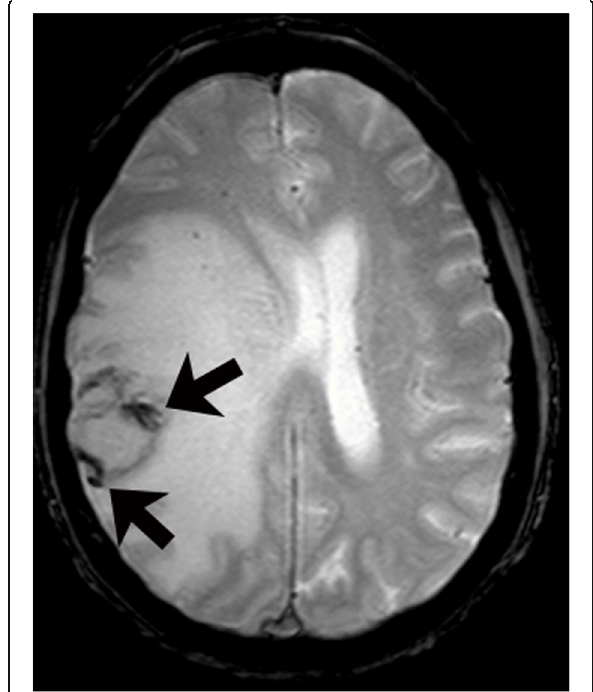
Fig. 4 Primary central nervous system post-transplant lymphoproliferative disorder. Gradient echo image shows a mass is in the right parietal lobe with surrounding vasogenic edema. Peripheral greater than central low gradient echo signal (arrows) within the mass are suggestive of hemorrhage